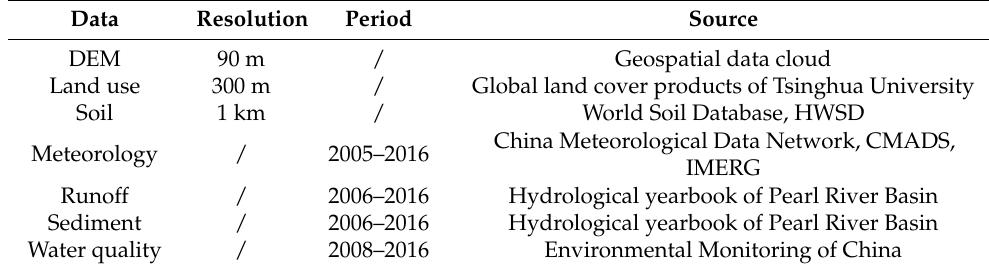
Table 1. Data sources used in this